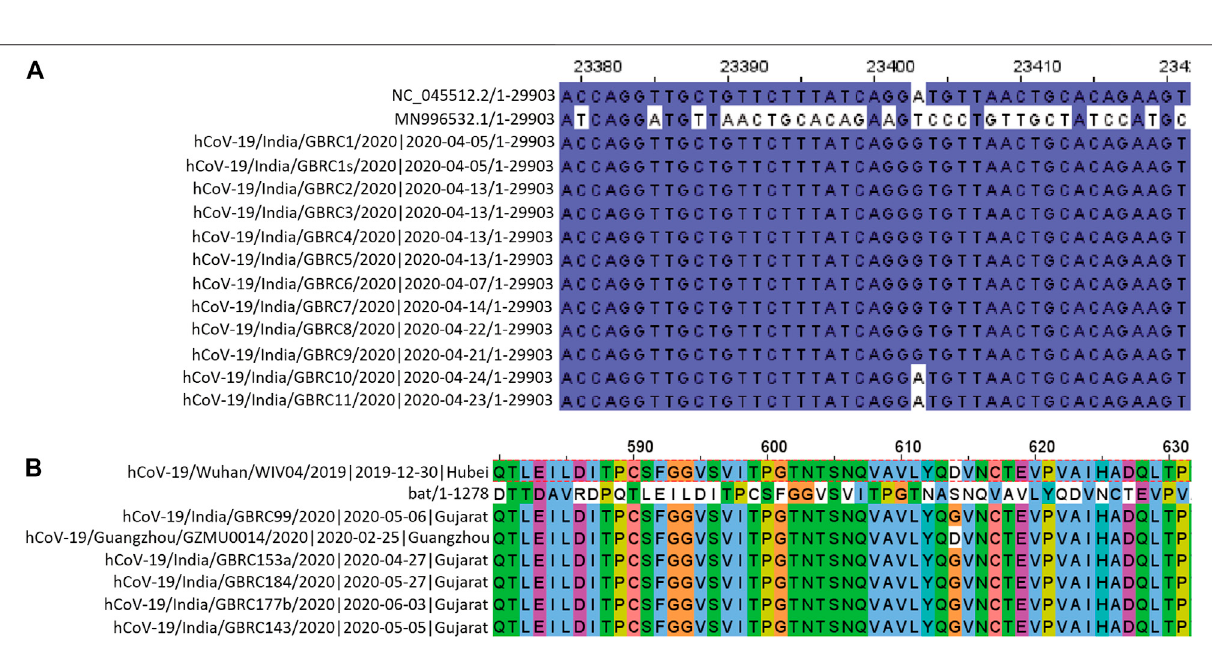
FIGURE 2 | (A) Change in the nucleotide at position 23403. NC_045512.2/1-29903 and MN996532.1/1-29855 are SARS-CoV-2 reference sequence and Bat CoV RaTG13 reference sequence, respectively. (B) Amino acid sequence alignment of spike protein encompassing the D614G